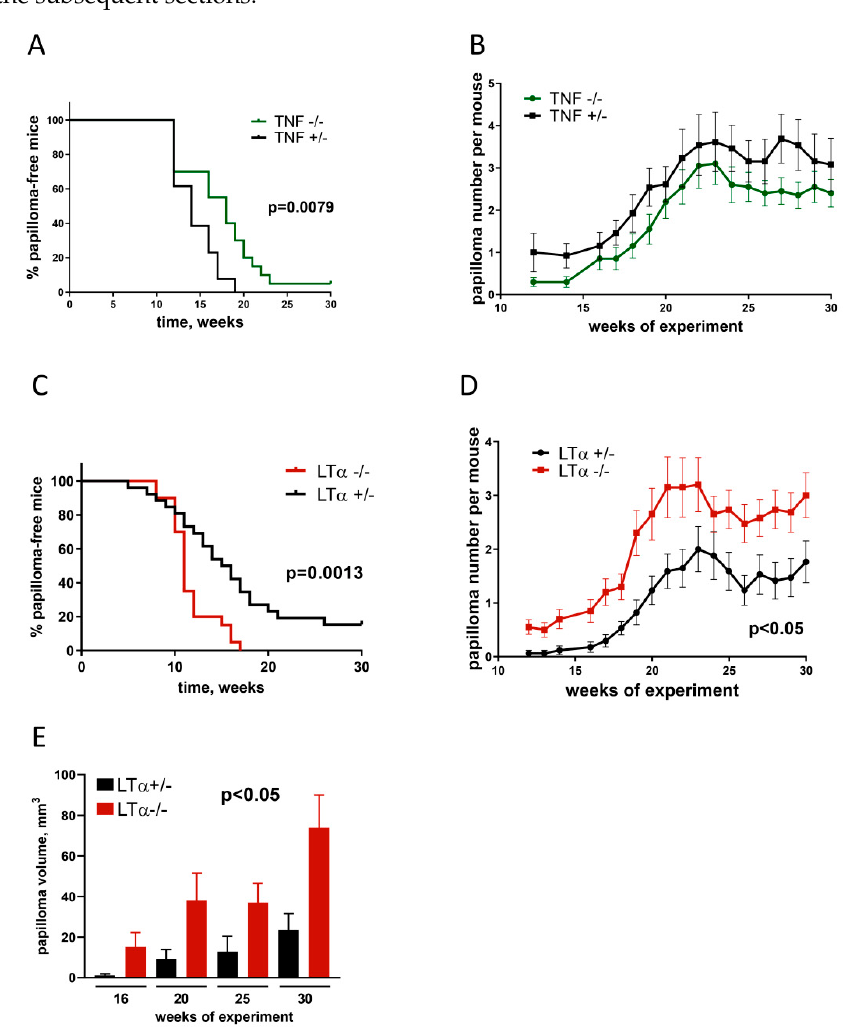
Figure 2. TNF-deficient mice with unperturbed LT α expression [3] are partially protected from DMBA/TPA skin carcinogenesis, while genetic LT α ablation sensitizes mice to this type of skin cancer. TNF-deficient mice were compared to heterozygous TNF +/ − co-housed littermate control mice. LT α -deficient mice were compared to heterozygous LT α +/ − co-housed littermate control mice. All animals aged 6–8 weeks were provided by the Unique Scientific Unit “Biomodel”, Branch of Shemyakin–Ovchinnikov Institute of Bioorganic Chemistry of the Russian Academy of Sciences (BIBCh, RAS), Pushchino, Moscow Region, Russia. The skin carcinogenesis was induced as previ- ously described [66]. Briefly, a single application of 25 mcg of DMBA in 100 mcl of acetone was administrated on day 0 to the shaved back skin area. TPA was administered at 4 mcg per 100 mcl acetone to the same area three times a week for 20 weeks. After that, mice were further monitored for an additional 20 weeks and papilloma formation and size were measured on a weekly basis.